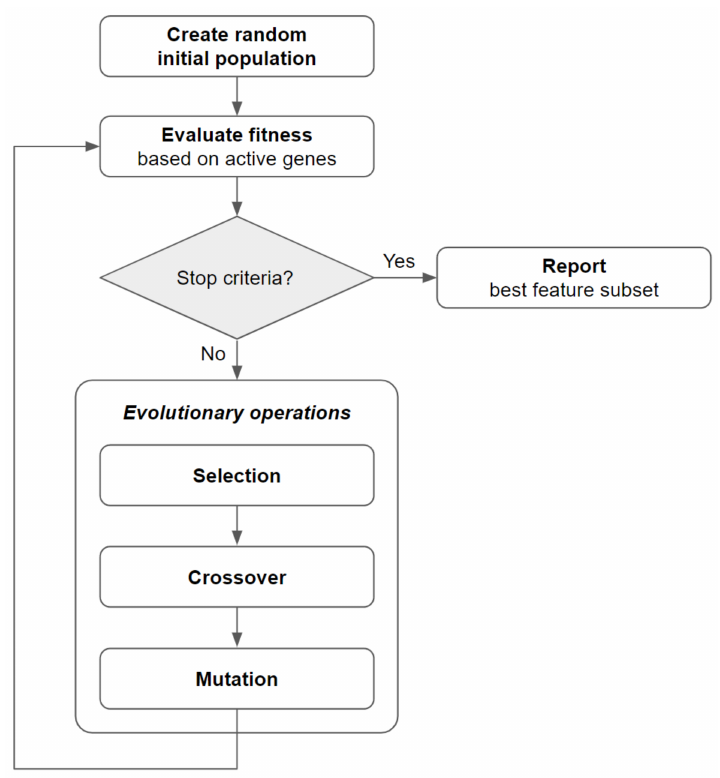
Figure 2. General process flow of a genetic